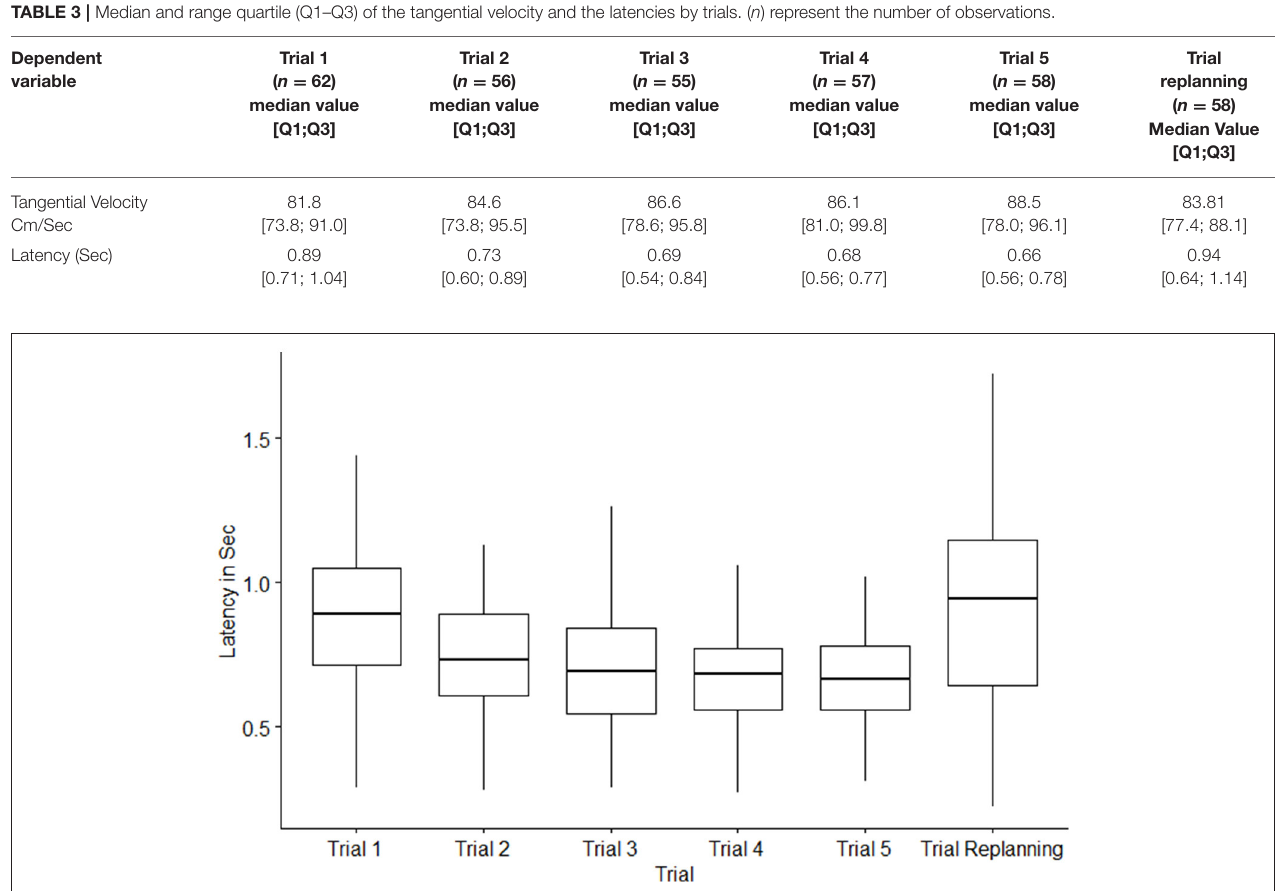
Frontiers in Psychiatry |